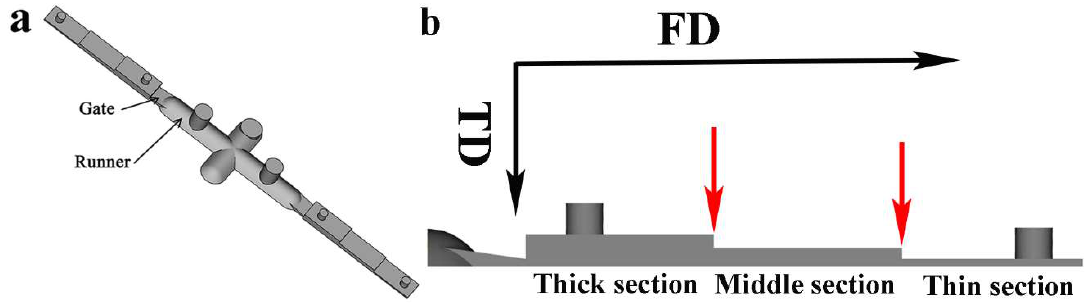
Figure 2. ( a ) 3D view of a final micropart; ( b ) three step decrease configuration of the micropart, the arrows indicate the boundary of each section.